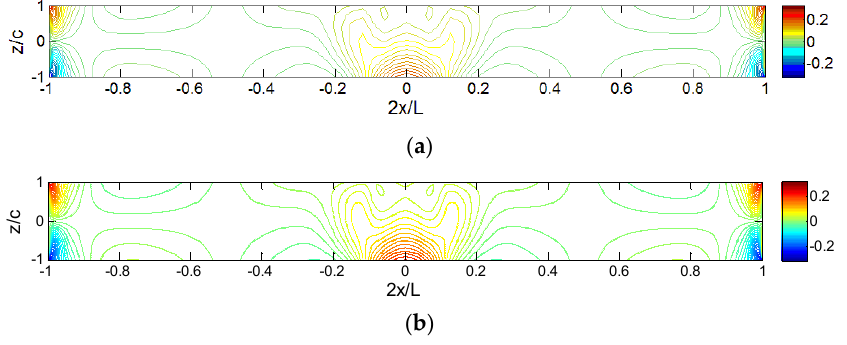
Figure 5. Comparisons of iso-stress ( σ xx / q ) diagram for sandwich panels under locally distributed loads ( L p = 0.1 L ): ( a ) HDQM; and ( b ) ABAQUS.